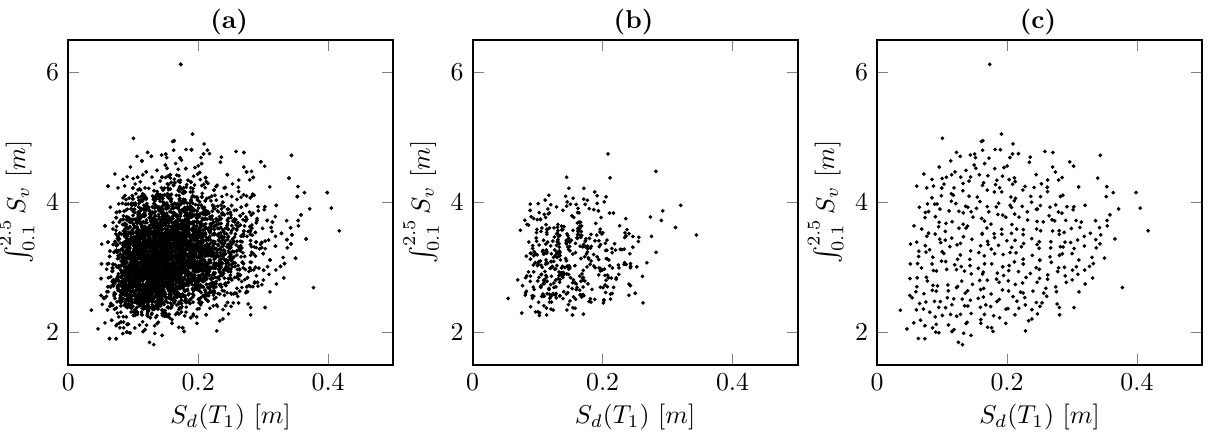
Figure 8. Two-dimensional selection strategy: selection of samples from ( a ) the full set the velocity spectrum intensity ( b ) randomly chosen samples for the training set set I t , sel